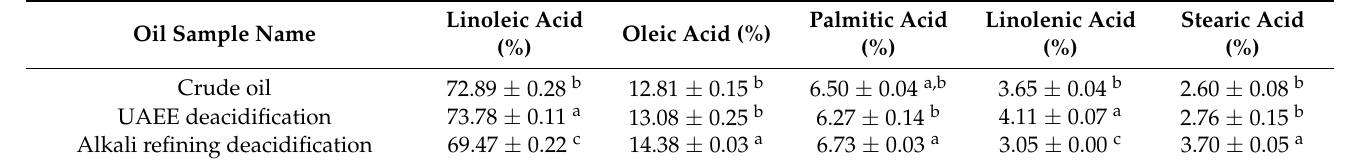
Table 4. Effect of deacidification methods on fatty acids of safflower seed oil.